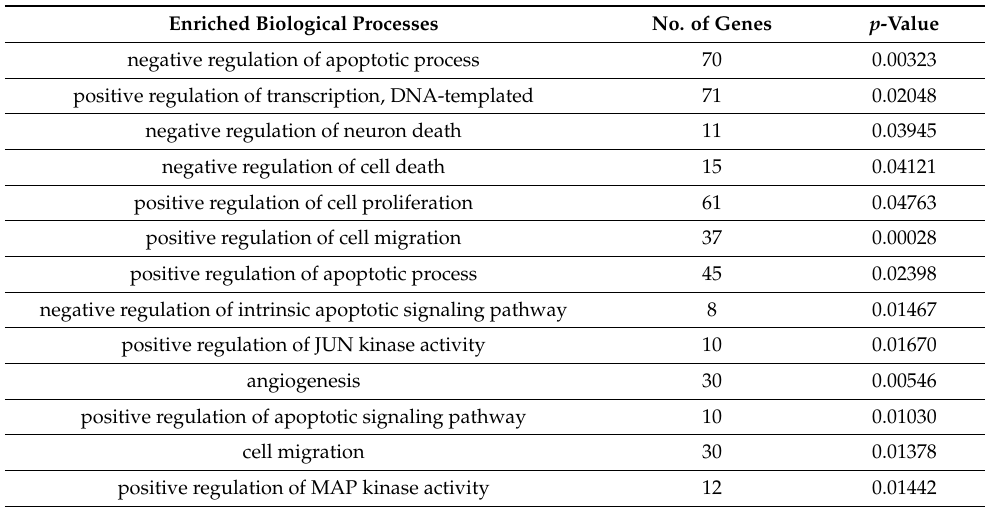
Table 2. Functional enrichment analysis of the predicted target genes of